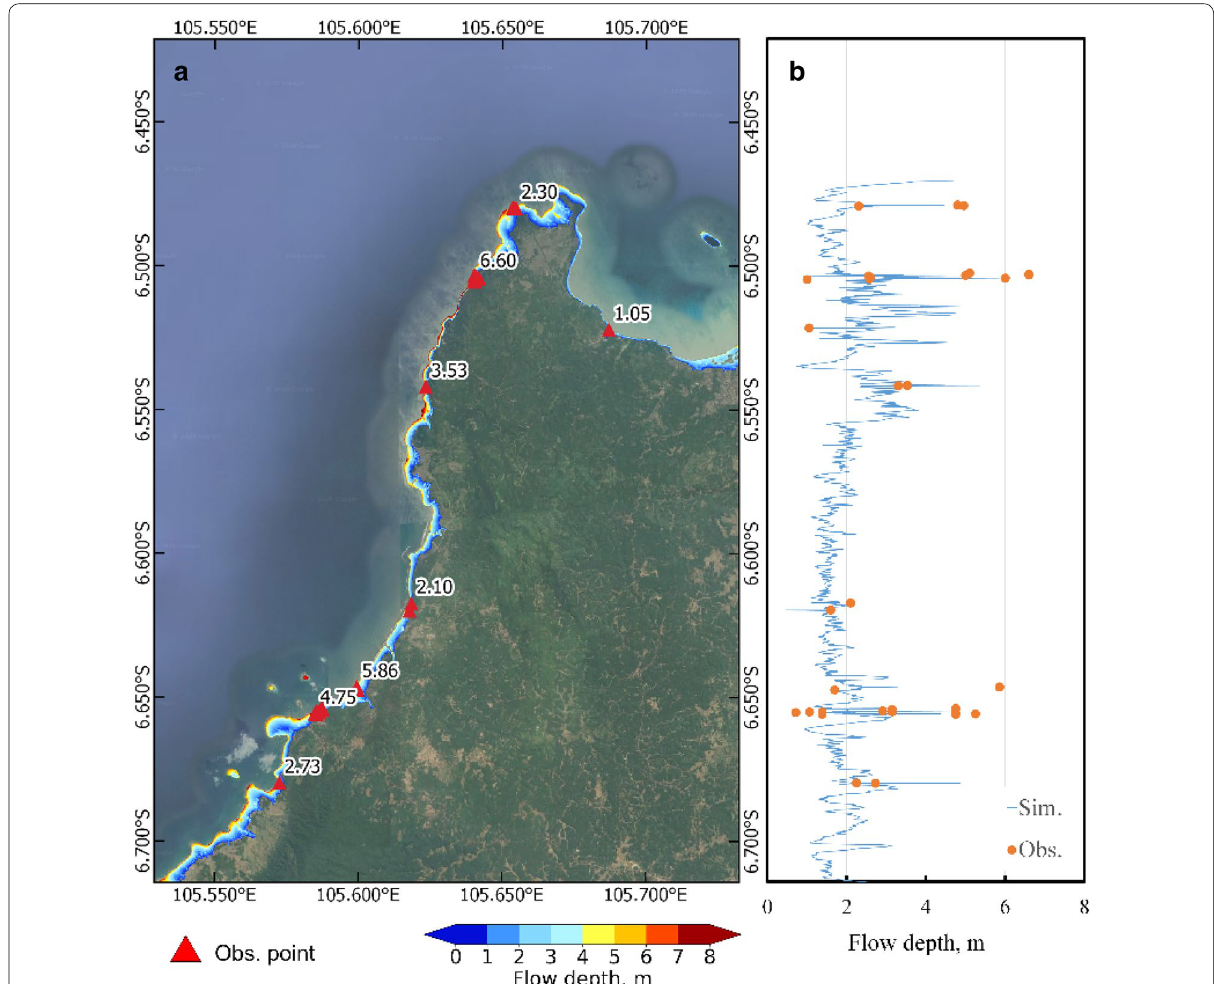
Fig. 13 Impact of the tsunami along the coastline in area B: a flood extent and locations of survey points; b water level along the coastline and comparison with observation